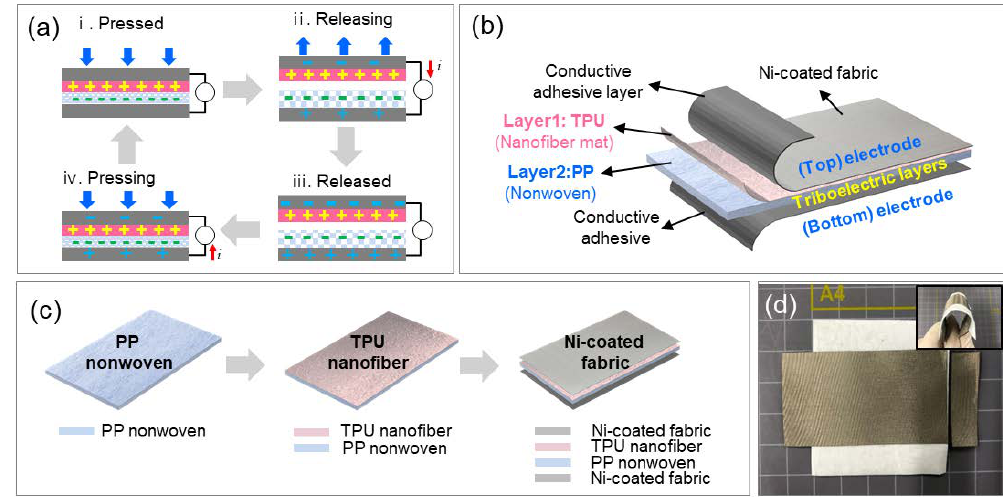
Figure 1. ( a ) Working principle of the TENG in vertical contact-separation mode, ( b ) design of the porous TPU / PP nonwoven fiber-based TENG, ( c ) schematic of the fabrication specimens, and ( d ) the image of a TENG